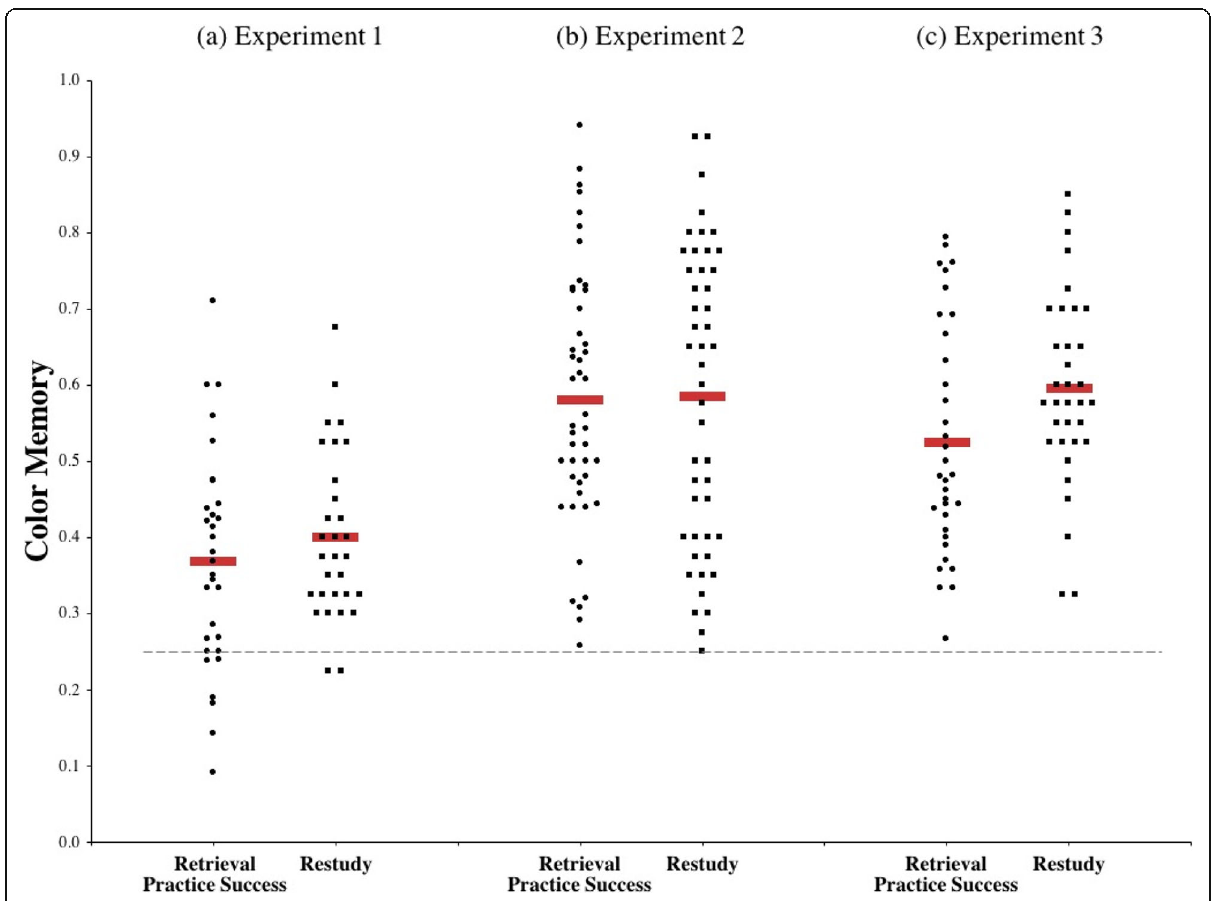
Fig. 2 Proportion correct on the color memory test from ( a ) Experiment 1, ( b ) Experiment 2 & ( c ) Experiment 3. Across all three experiments, successful retrieval practice did not result in improved memory for source details from the original study event (font color). Each dot or square represents one participant. The red bars indicate the mean score in each condition and the dashed line indicates chance performance